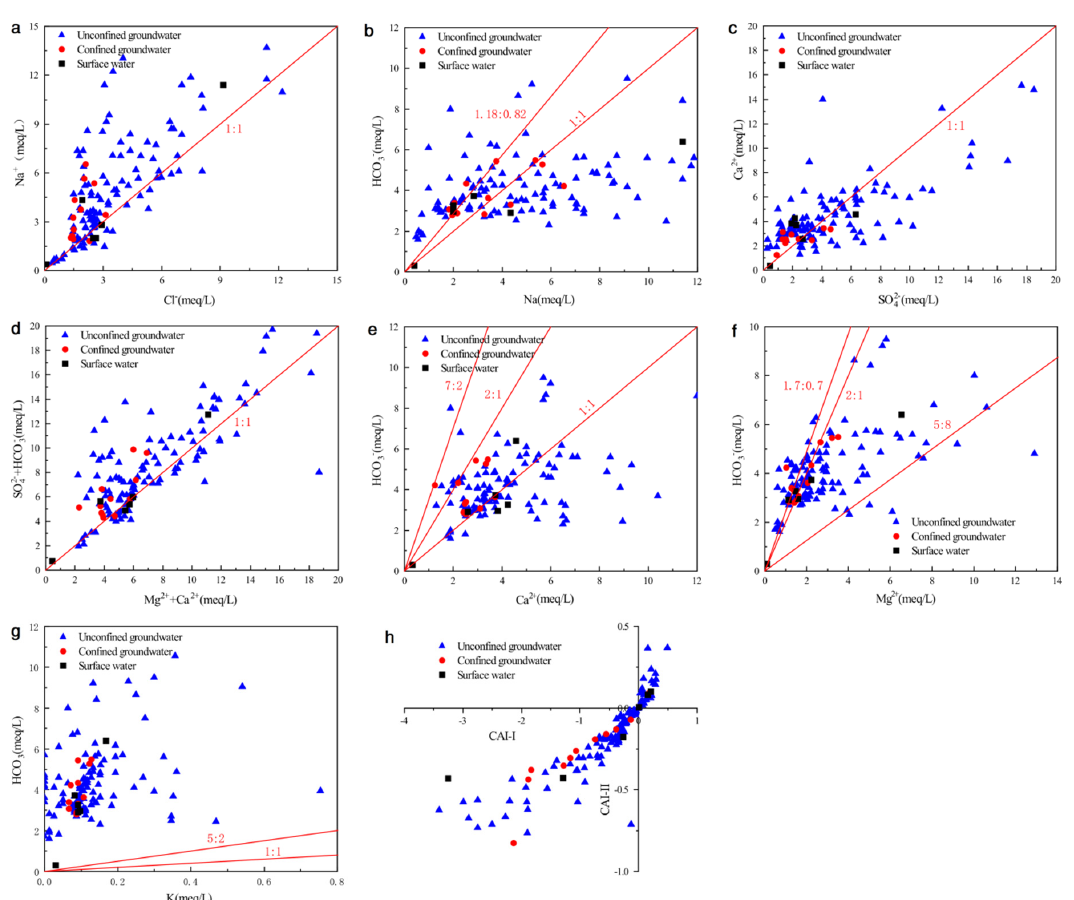
Figure 6. Scatter plots showing the correlation of major cations/anions to discriminate the geochemical processes. ( a ) Na + vs. Cl − , ( b ) Na + vs. HCO 3 − , ( c ) Ca 2+ vs. SO 42 − , ( d ) (SO 42- +HCO 3 − ) vs. (Ca 2+ +Mg 2+ ), ( e ) processes. ( a ) Na + vs. Cl − , ( b ) Na + vs. HCO 3 − , ( c ) Ca 2 + vs. SO 42 − , ( d ) (SO 42- + HCO 3 − ) vs. Ca 2+ vs. HCO 3 − , ( f ) Mg 2+ vs. HCO 3 − , ( g )HCO 3 − vs. K + , ( h ) scatter plot of Schoeller indices. (Ca 2 + + Mg 2 + ), ( e ) Ca 2 + vs. HCO 3 − , ( f ) Mg 2 + vs. HCO 3 − , ( g )HCO 3 − vs. K + , ( h ) scatter plot of Schoeller